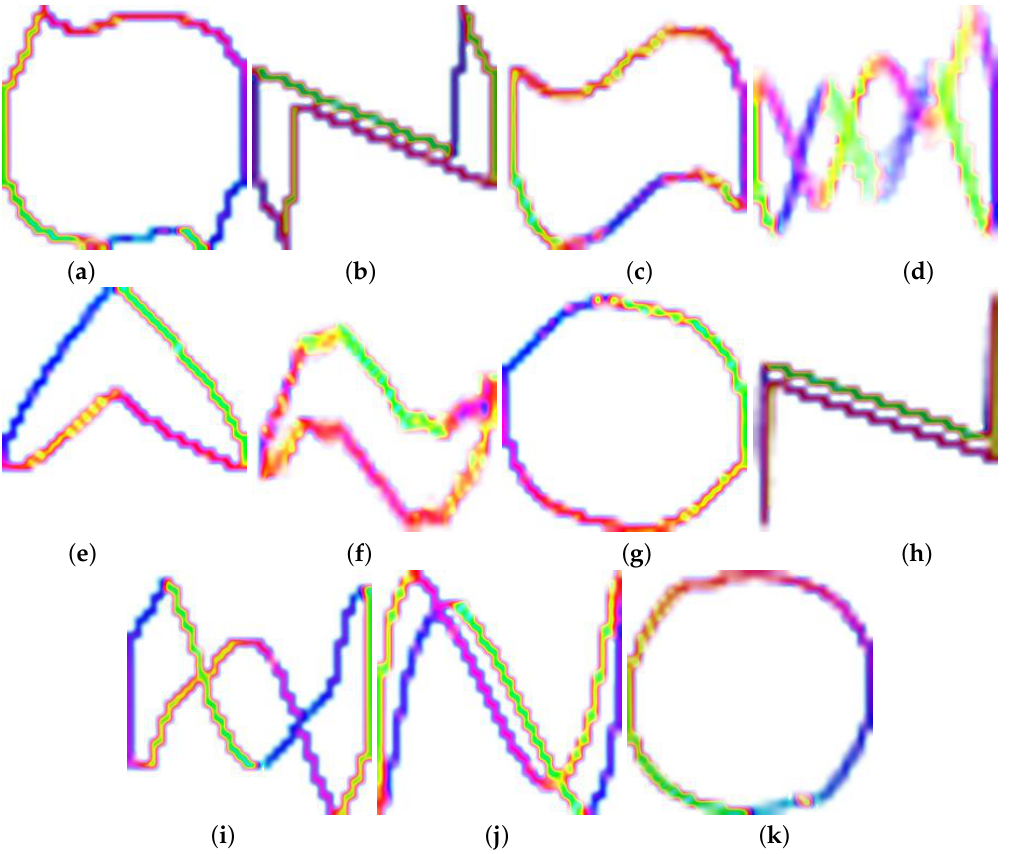
Figure 6. The generated color images of ( a ) air conditioner, ( b ) compact fluorescent lamp, ( c ) fan, ( d ) fridge, ( e ) hairdryer, ( f ) heater, ( g ) incandescent light bulb, ( h ) laptop, ( i ) microwave, ( j ) vacuum, and ( k ) washing machine for PLAID